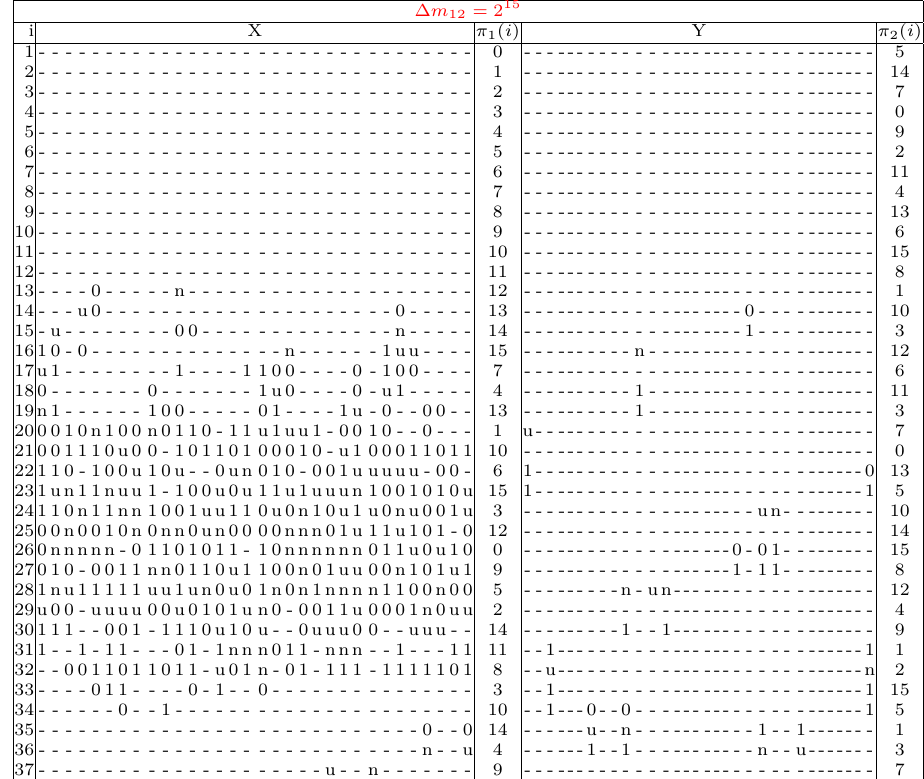
Table 13: 37-step differential